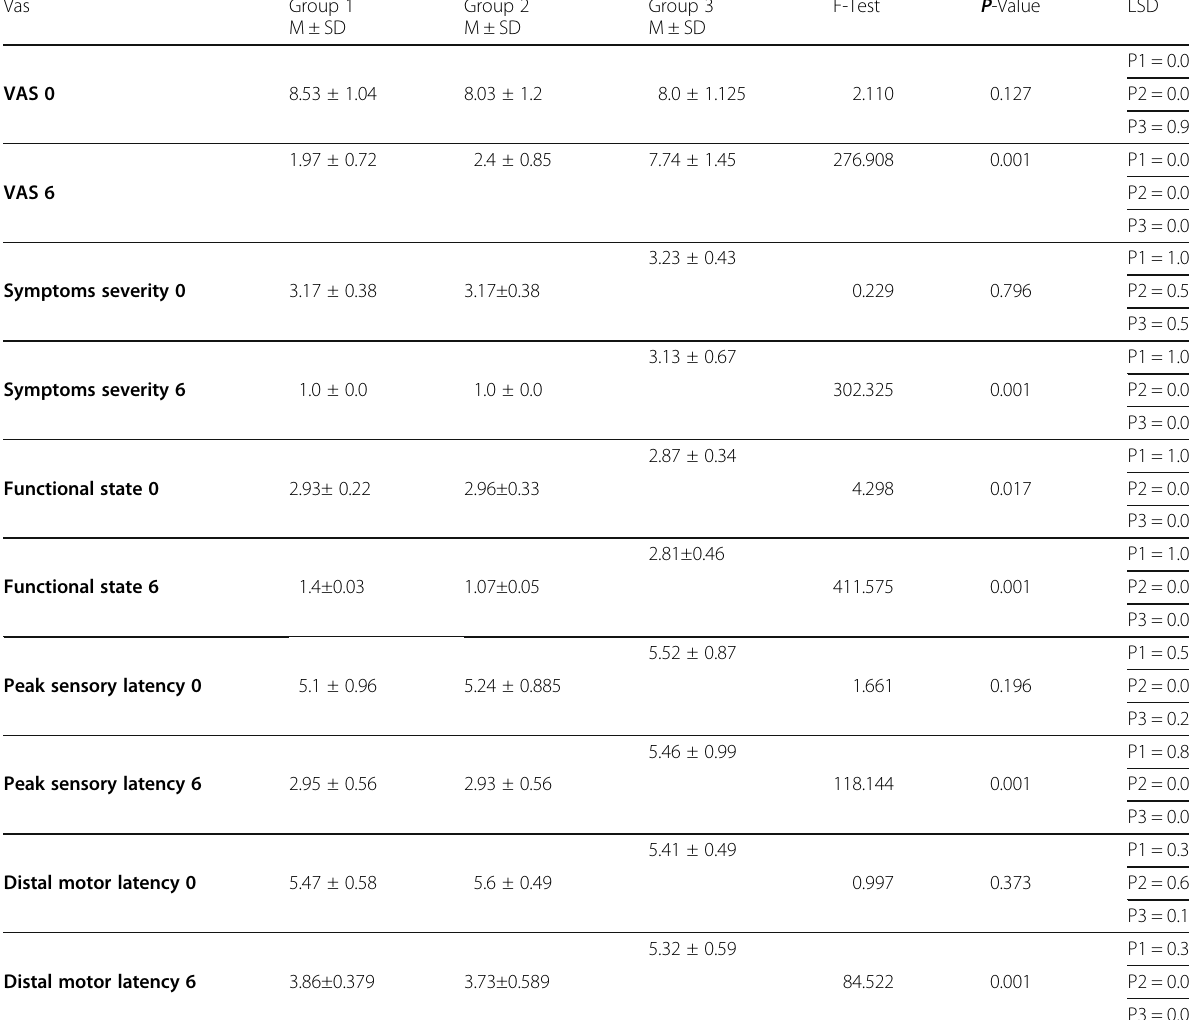
Table 5 Visual analogue scale and Boston questionnaire of CTS and electrophysiological parameters among the three groups of patients at baseline and at 6 months post